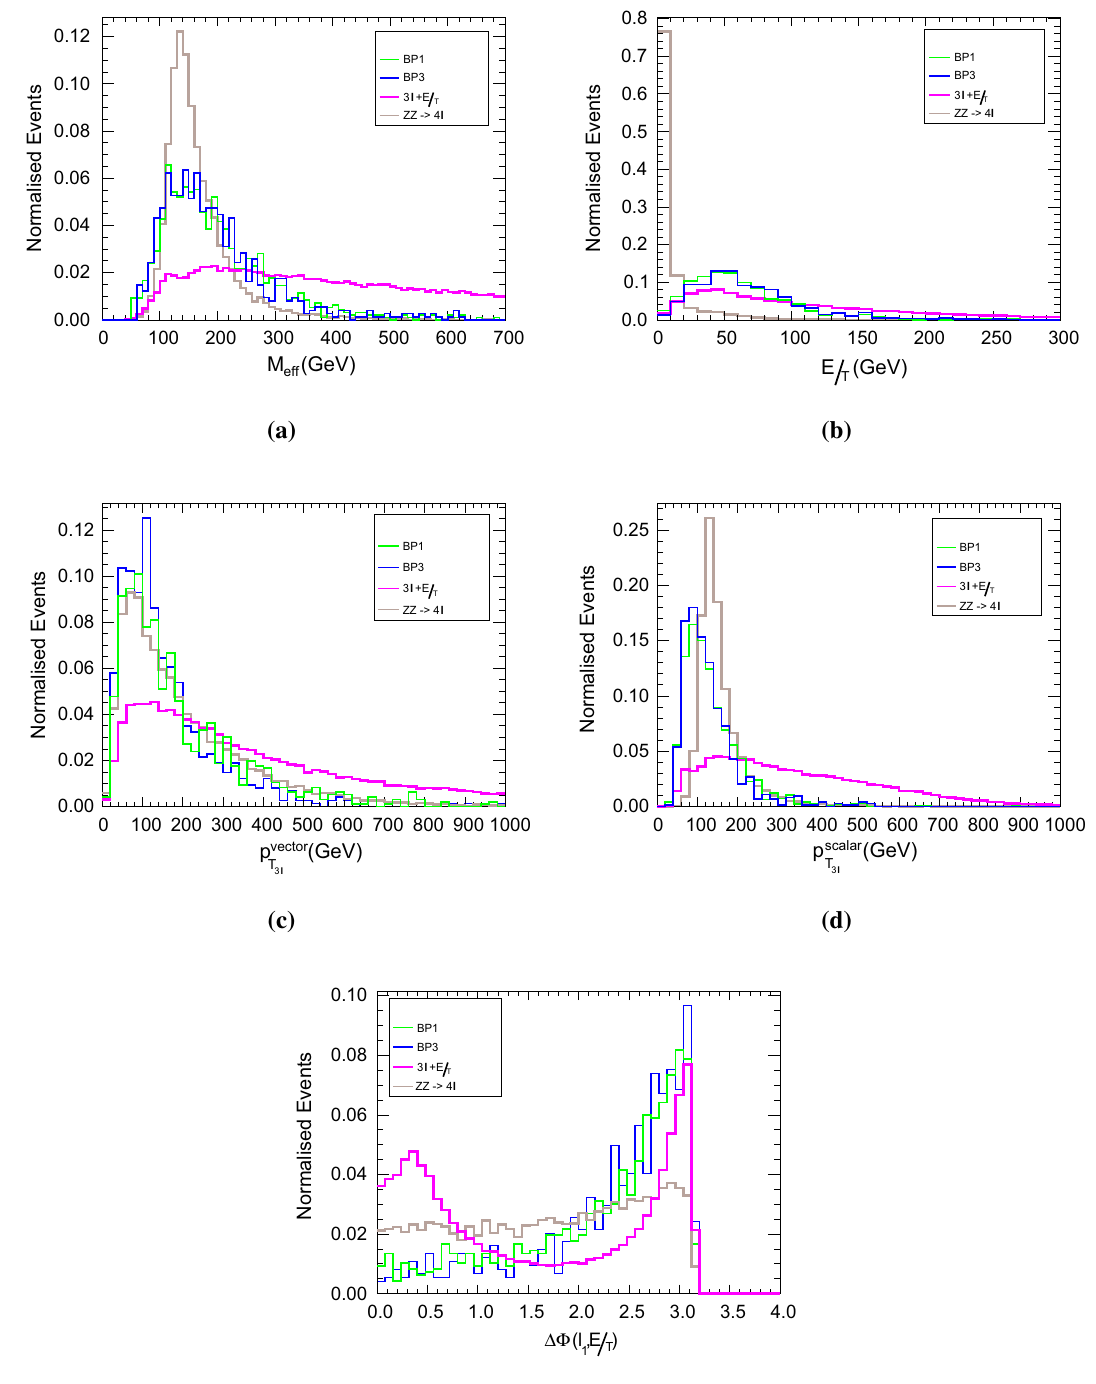
, p scalar , (cid:11)φ (cid:3) for 3 (cid:3) + E T / channel at 14 TeV T , tot T , tot 1 , E T /